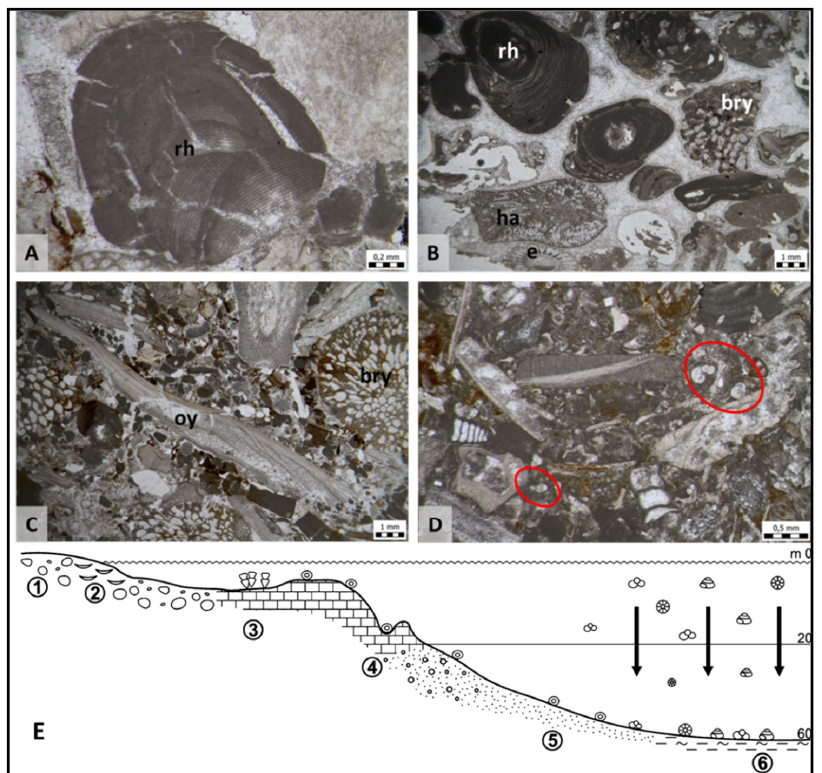
Figure 11. Photomicrographs of slides from the Marija Bistrica site (NE Medvednica Mt., Figure 10), representing a succession from a rapidly drowned Miocene ramp (from the research in [65]; un- published). ( A ) Rhodolith (rh) with desiccation cracks in outer layers, from the basal parts of the transgressive sequence (see 11 (E)/environment 1). ( B ) Algal bryozoan rudstone from a shallow la ‐ goon (11 (E)/environment 3). Rhodolith (rh), Bryozoan (bry) and halimeda (ha) marked on the photo. ( C ) Bryozoan floatstone with oyster (oy) fragments deposited on inner shelf (11 (E)/environ ‐ ment 4). ( D ) Floatstone with fragments of shelf biota, transported downslope and mixed with plank ‐ tonic foraminifera (see red ellipses) (11 (E)/environments 4 and 5). ( E ) Reconstruction of the pale ‐ oenvironment during the Middle Miocene at the research locality, from [65] (assemblages recon ‐ structed after [119]; sedimentary features after [120]). Numbers indicate the following environ ‐ ments: 1. Beach and proximal shelf; 2. Oyster banks; 3. Lagoons and embayments; 4. Patch reefs and surrounding bioclastic deposits; 5. Maërl; 6. Distal slope. Dimensions not to scale.